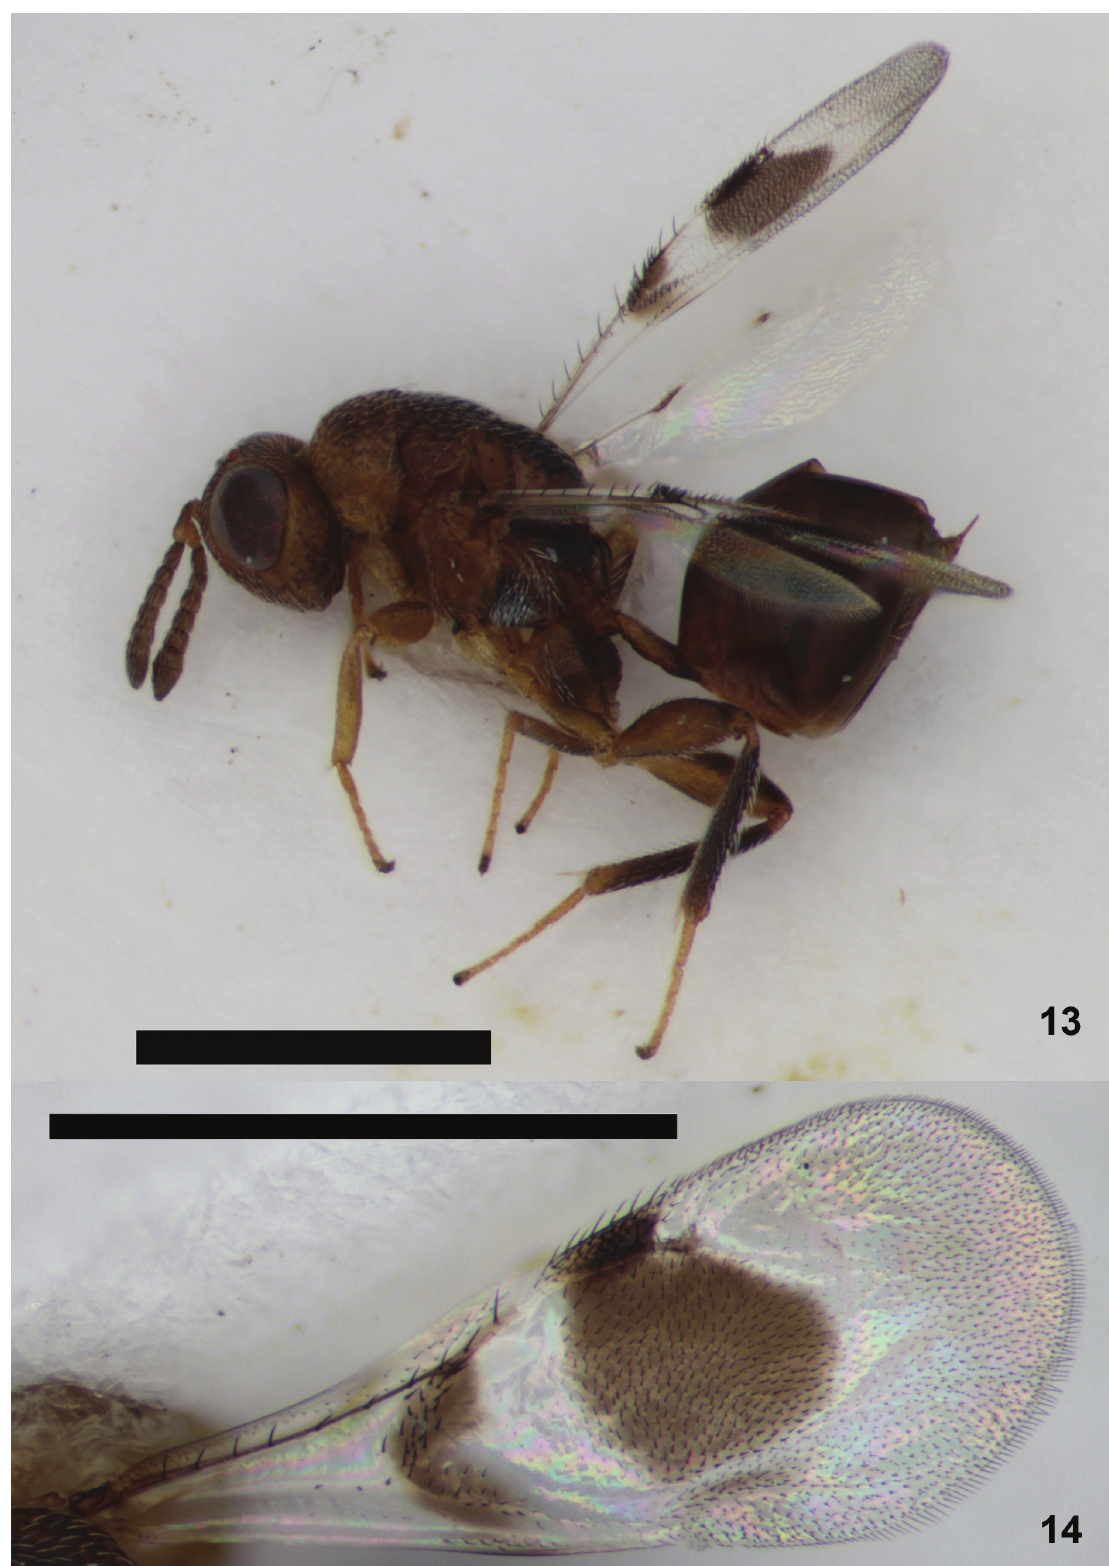
Figs 13–14. Sycophila binotata Fonscolombe, 1832, ♀. 13 . Lateral habitus. 14 . Fore wing. Specimen number bMNh(e)969430. Scale bars both 1 mm. © Natural history Museum,